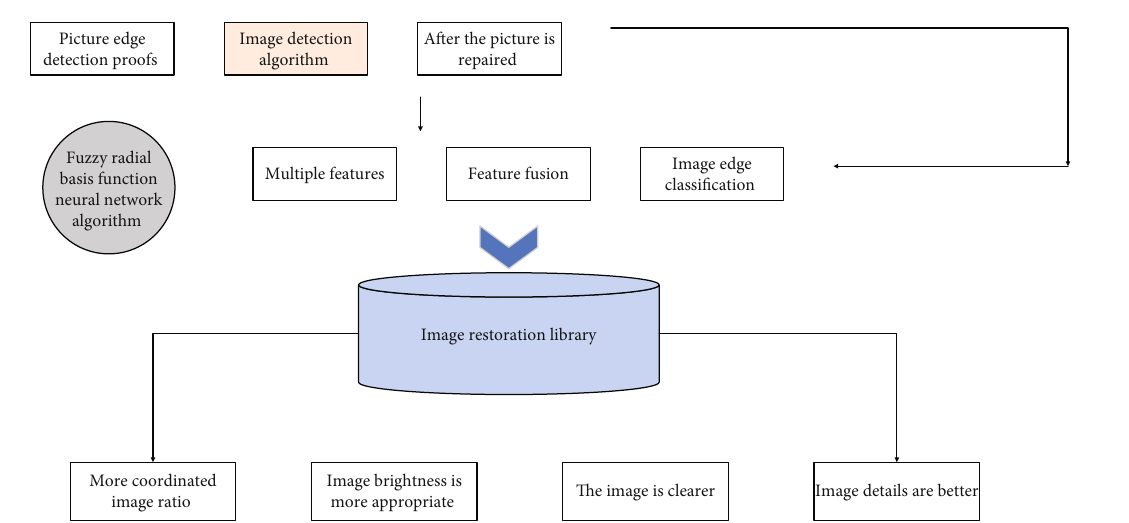
Figure 2: The implementation process of fuzzy radial basis fusion discrimination for image edge